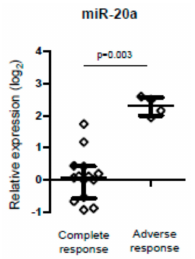
Figure 3. Relative expression of miR-20a after chemotherapy treatment in individuals with cHL according to clinical outcome, i.e., complete versus adverse response (Mann-Whitney U